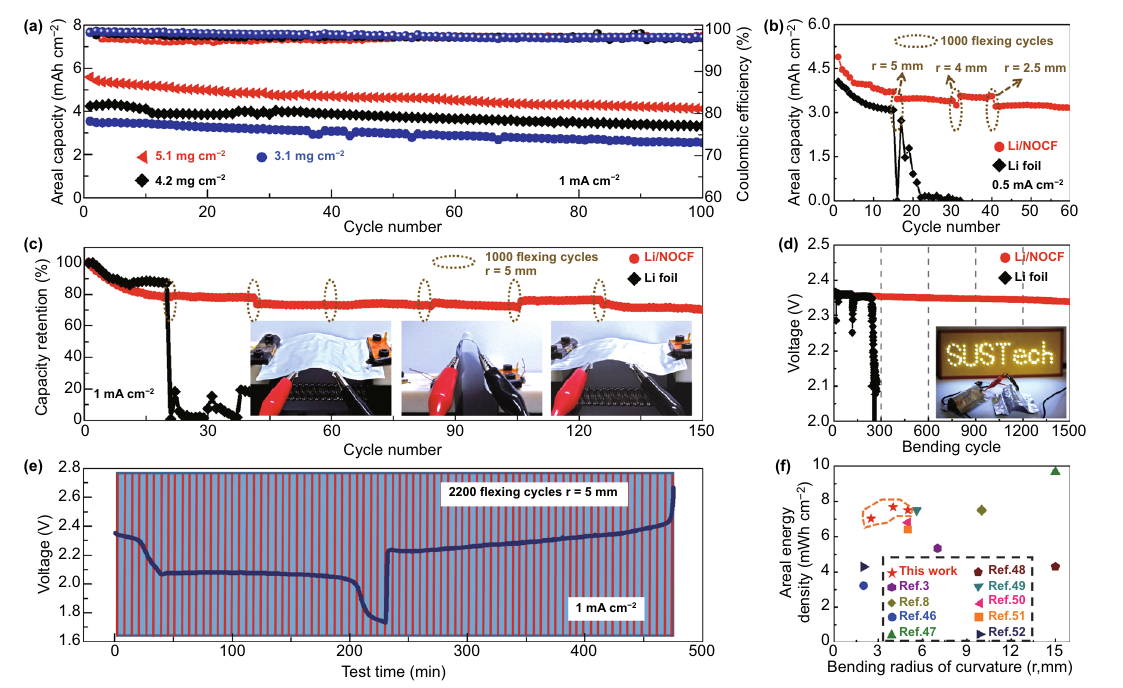
Fig. 5 a Cycling stability of Li–S full cells (denoted as Li/NOCF//SP/S/NOCF) with various sulfur loadings of 5.1, 4.2, and 3.1 mg cm −2 along with 90% oversized Li. b Areal capacities of Li–S full cells with an electrode size of 6.0 cm −2 and high sulfur loadings of 3.9 mg cm −2 are recorded at 0.5 mA cm −2 for 60 cycles, during which 3000 flexing cycles are applied for Li//SP/S/NOCF and Li/NOCF//SP/S/NOCF at bending radii of 5.0, 4.0, and 2.5 mm. c Capacity retention of Li/NOCF//SP/S/NOCF full cells (S loading: 3.3 mg cm −2 ) is recorded during 6000 bend- ing cycles at a bending radius of 5 mm. Insets are optical images of Li–S full cells during flexing process. d Voltage stability of Li–S full cells (S loading: 3.3 mg cm −2 ) during flexing process at a bending radius of 5 mm with a bending rate of 10 mm s −1 . e Charge/discharge curves of Li/ NOCF//SP/S/NOCF full batteries (S loading: 3.8 mg cm −2 ) during 2200 in situ flexing cycles with a bending rate of 10 mm s −1 . f Figure of merit (FOM, E a / r ) of Li/NOCF//SP/S/NOCF full cells and previously reported Li–S cells [3, 8,